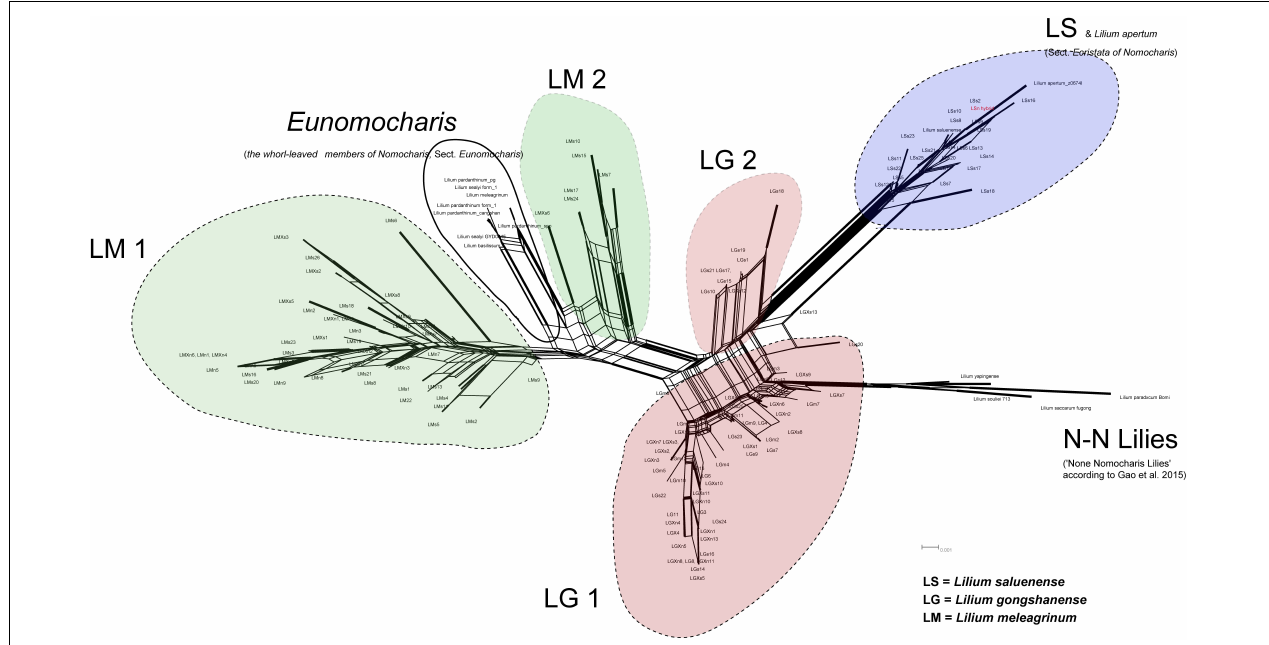
FIGURE 4 | Unrooted phylogenetic network of ITS sequence conducted in SplitsTree4 (Huson and Bryant, 2006) using the NeighborNet algorithm with Kimura 2-parameter (K2P) distances and ordinary least-squares inference of branch lengths. Confidences based on bootstrap of 1,000 replicates were demonstrated by edge width.